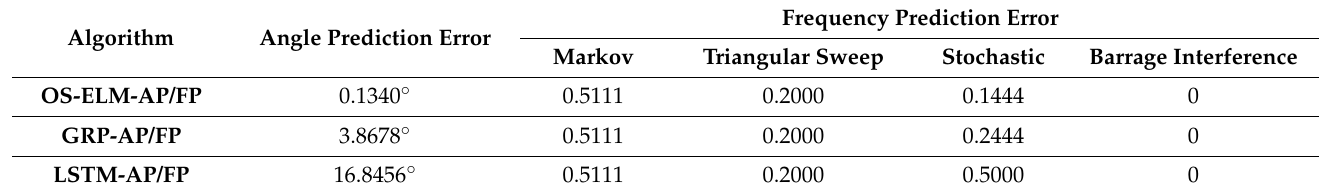
Table 6. Average continuous multi-time prediction error.